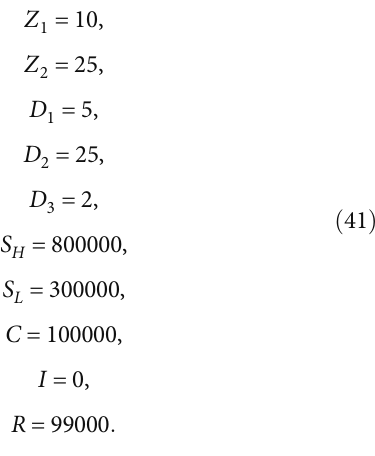
Table 4 and the following values for the weights and state var- iables to obtain the numerical